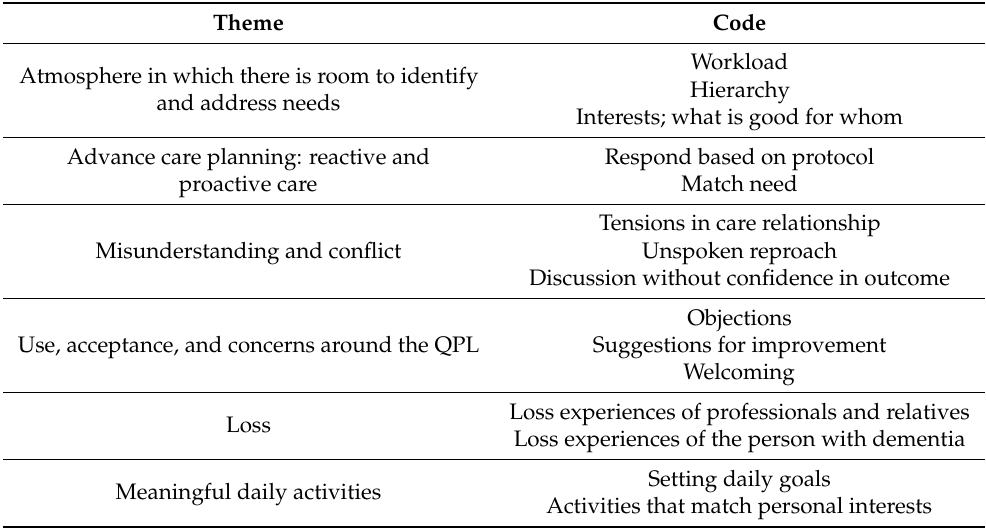
Table 1. Selected codes addressing the research questions in the interviews and fieldnotes. Theme